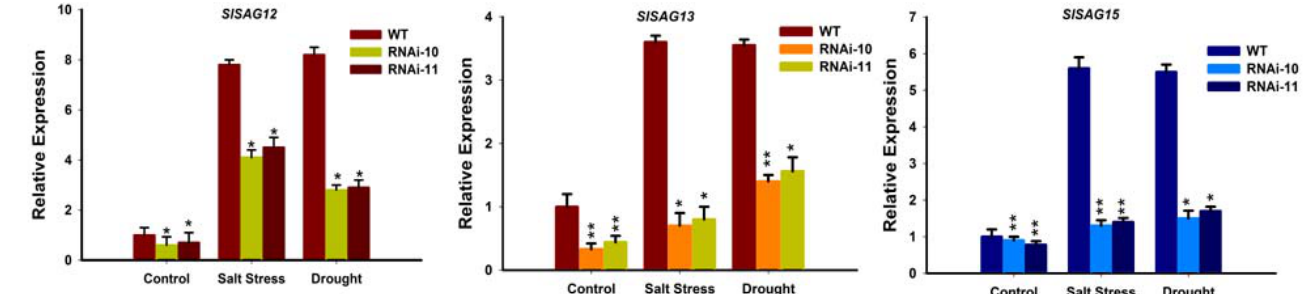
Figure 11. Expression of senescence-associated genes in SlGRAS10 -RNAi under stress conditions. Expression analysis of SlSAG12 , SlSAG13, and SlSAG15 genes in SlGRAS10 -RNAi (L10, L11) and WT after control, salt, and drought stress treatments. The date represents the mean ± SE of three independent replicates. *, ** indicates a significant difference ( p < 0.05, p < 0.01) between transgenic and wild-type